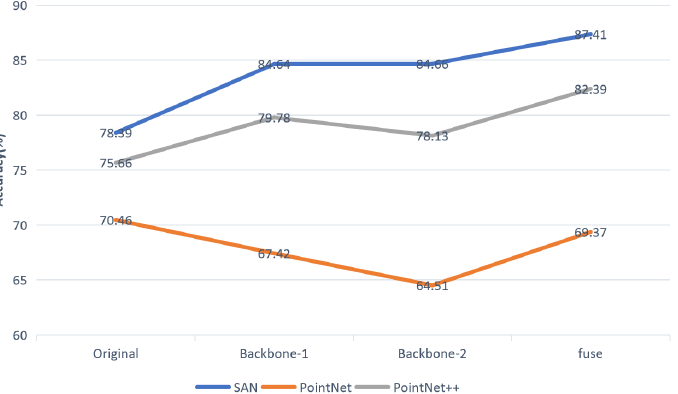
Figure 12. Results by our approach on S3DIS using SAN, PointNet and PointNet++ as backbone network. Where original is the experimental result of directly using the backbone